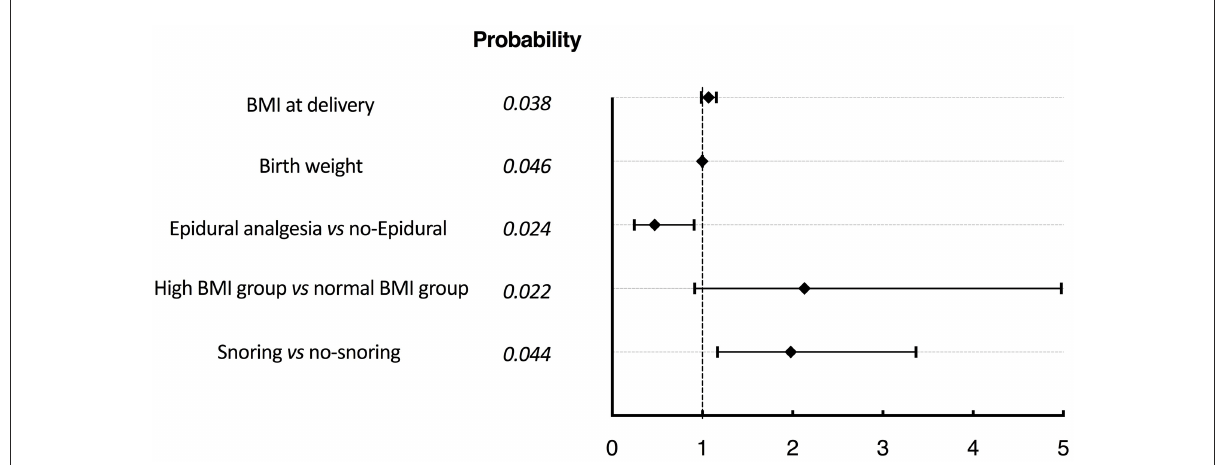
FIGURE3 Forest plot for regression analysis of related factors affecting ULBT classification increasing after delivery. BMI, Body Mass Index; ULBT, upper lip bite test. Adjusting for these confounding factors, the binomial logistic regression analysis further confirmed that the risk of an increased ULBT class after delivery was 2.13 times higher in the high BMI group than in the normal BMI group (aOR = 2.13 [0.91–4.98], P =